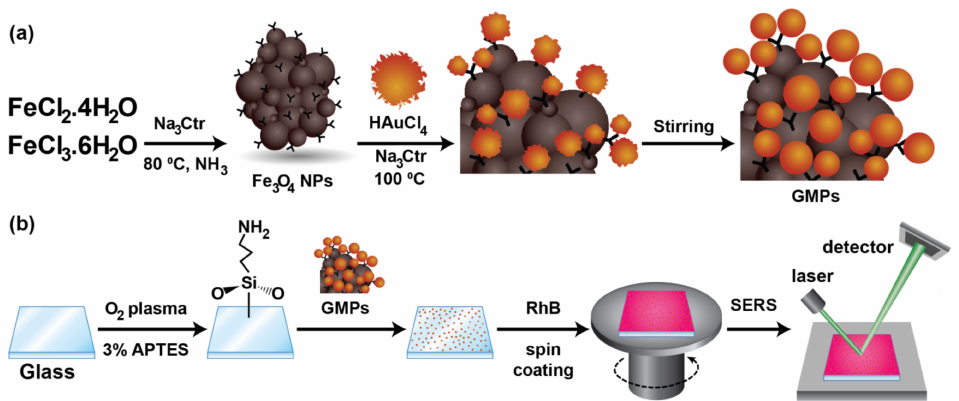
Figure 1. ( a ) A schematic of the synthesis of Fe 3 O 4 NPs and GMPs. ( b ) The procedures for SERS substrate preparation and